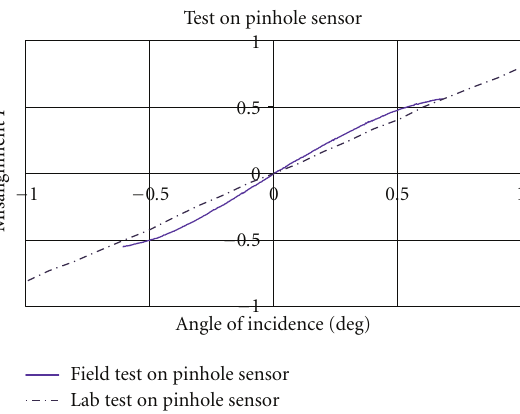
Figure 13: (a) Output signals for Slit Sensor. (b) Misalignment for Slit Sensor.